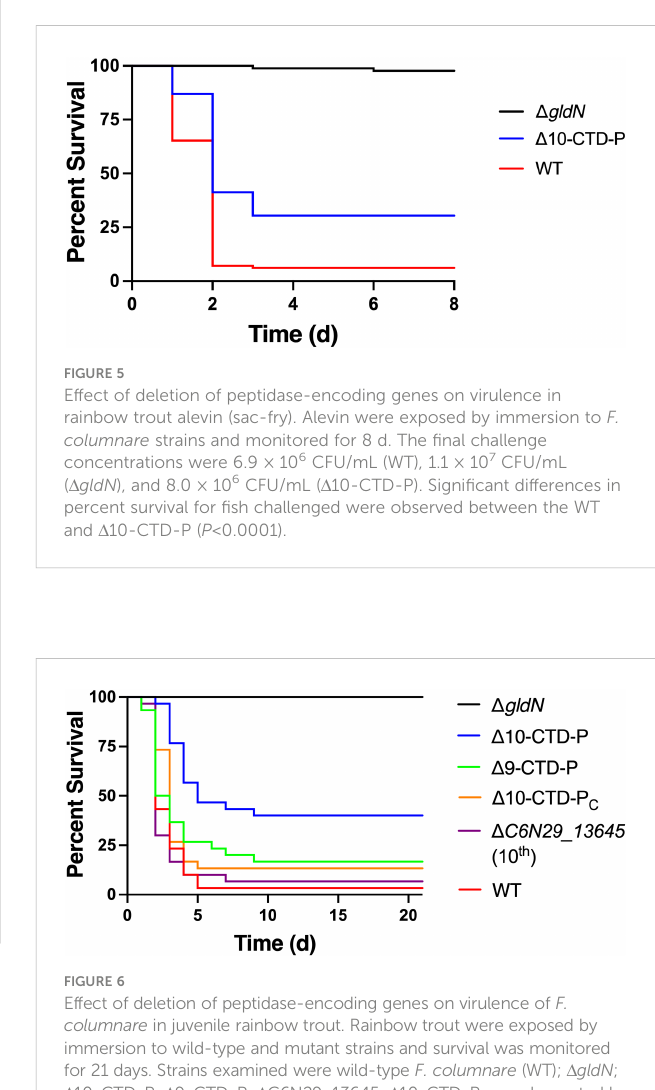
(Figure 6). D C6N29_13645 displayed similar virulence to wild type, indicating that deletion of the single gene, C6N29_13645, was not responsible for the defect in virulence observed in D 10 CTD-P.